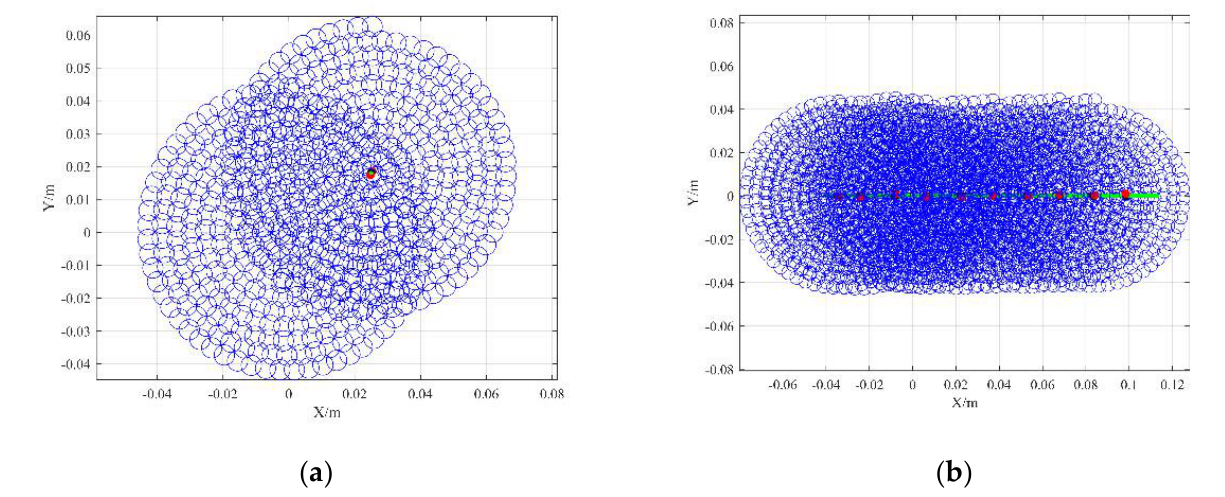
Figure 7. The simulation of the APT of a point target: ( a ) the acquisition and pointing of a static target ( x 0 = 0.025, y 0 = 0.018, v = 0, α = 0, z (cid:48) = 3.26); ( b ) the APT of a dynamic target ( x 0 = − 0.04, y 0 = 0, v = 0.01, α = 0, z (cid:48) =